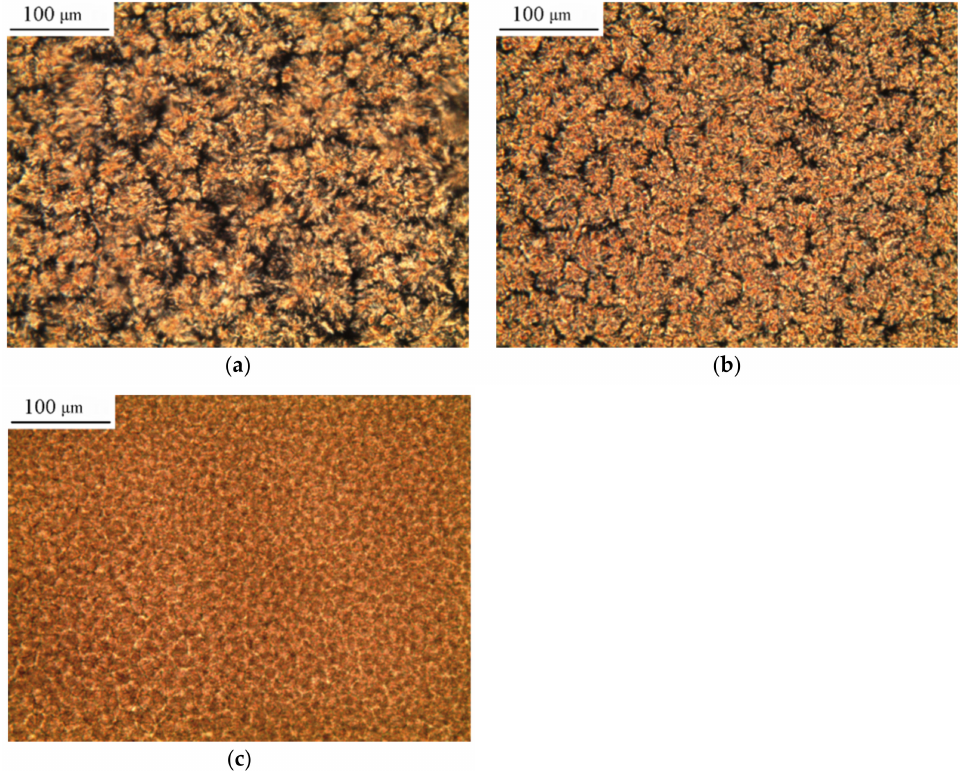
Figure 7. Polarized optical micrographs of PCL (M n = 45 × 10 3 ) – DGEBA mixtures with ϕ PCL ( a ) 0.23; ( b ) 0.38; ( c ) 0.52.